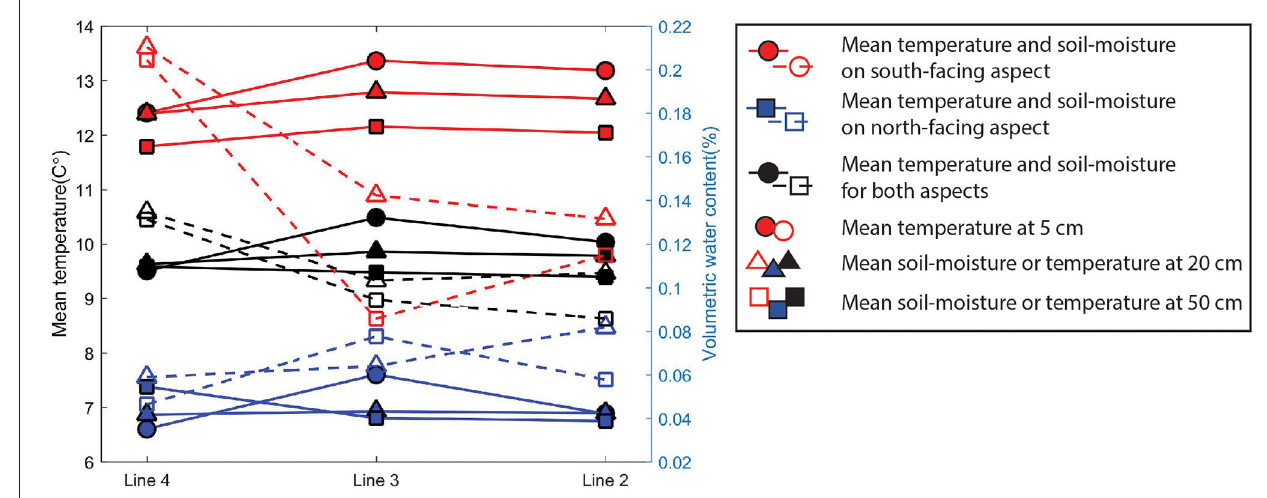
FIGURE 10 | The mean volumetric water content and temperature for the 2012 water year at 5, 20, and 50cm for both aspects and as an average of the aspects. The dotted lines and hollow shapes indicate volumetric water content, while the solid lines and shapes are temperature. Blue lines and shapes indicate the north-facing aspect, red the south-facing, and black the mean of the measurements of both aspects. The mean volumetric water content and temperature for both aspects, black lines and shapes, was calculated by averaging the measured volumetric water content and soil temperature at each paired instrument site. For the sake of clarity the volumetric water content at 5cm is not shown.